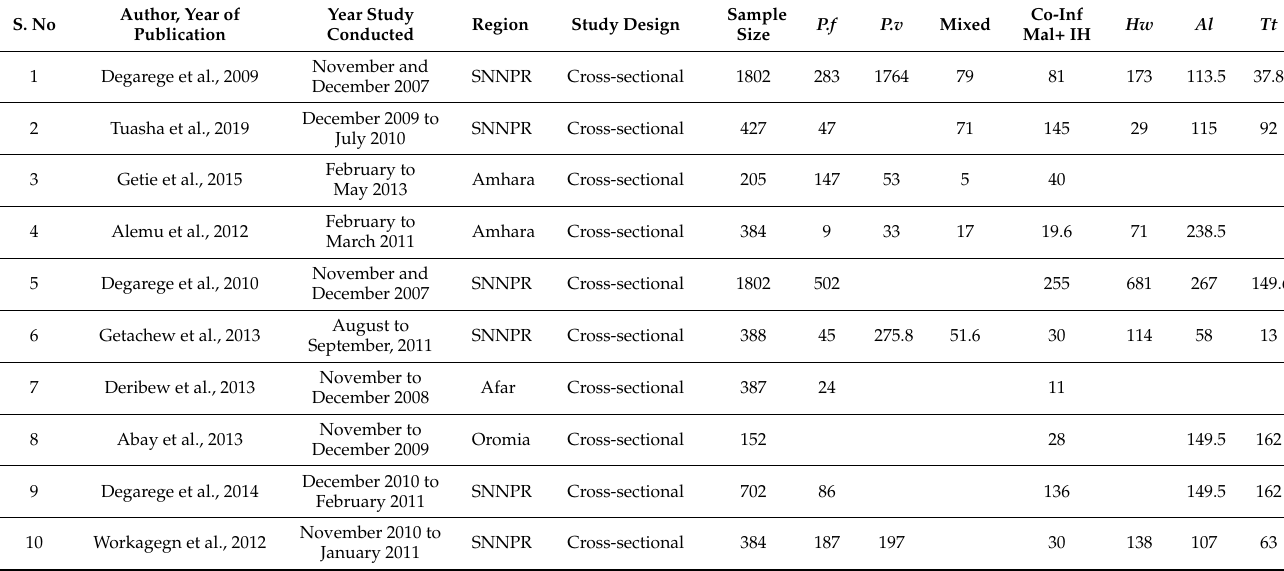
Table 2. Summary characteristics of 10 studies included in the systematic review and meta-analysis of comorbidity of geo-helminthes and malaria among outpatients in